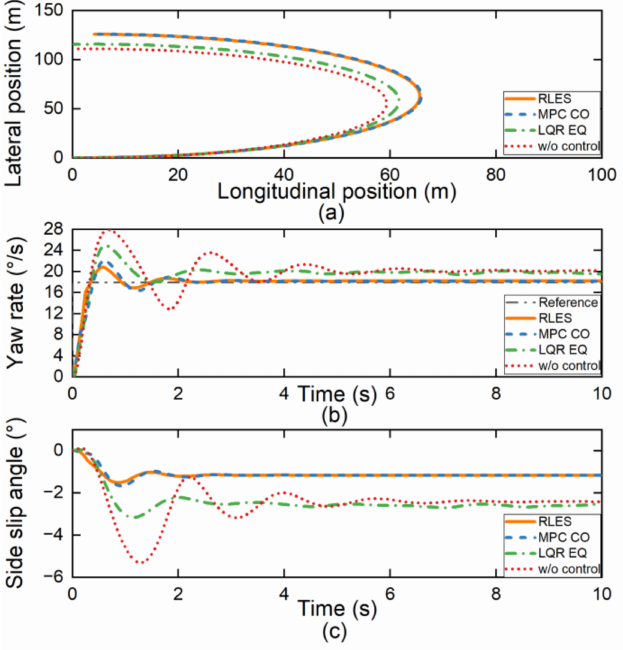
Figure 12. Simulation results under step steering maneuver. ( a ) Vehicle displacement; ( b ) yaw rate; ( c ) side slip angle.